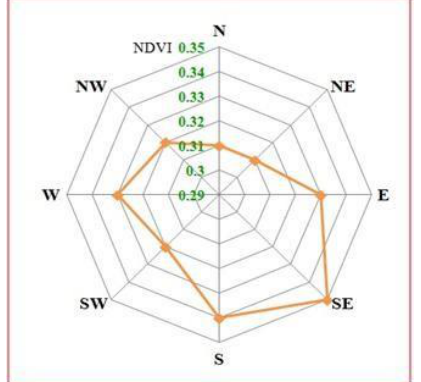
Figure 5. Change in NDVI value with